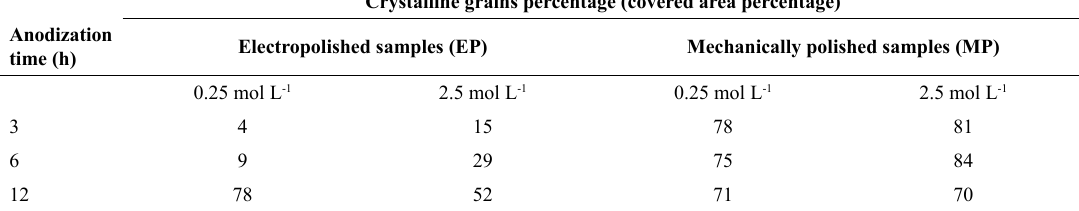
Table 2. Quantitative analysis results using an image processor.